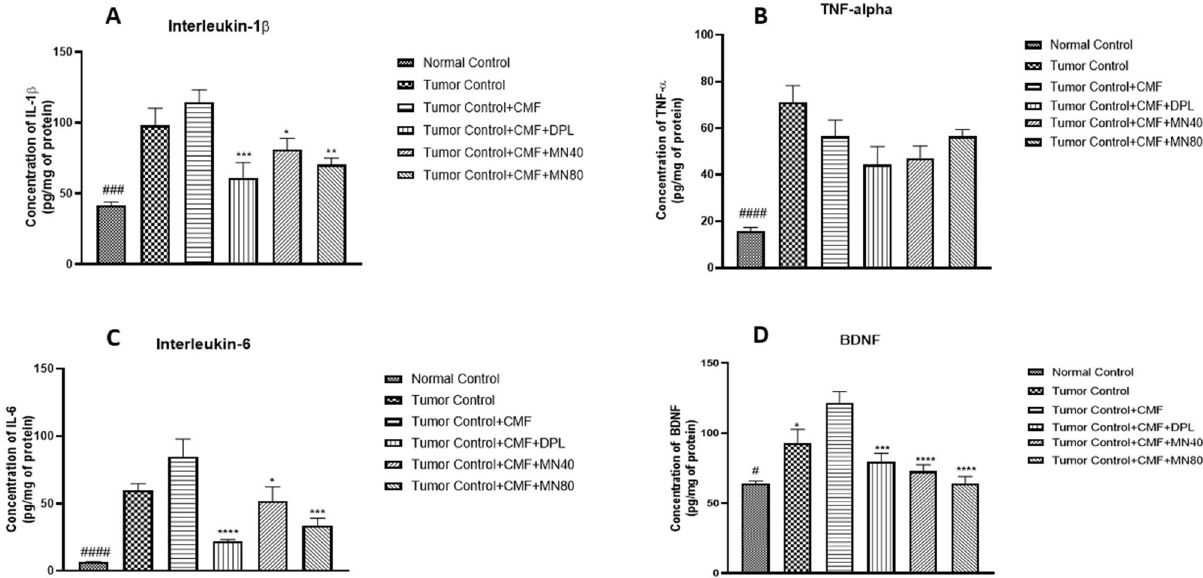
Figure 9. Effect of Mulmina (MN), Cyclophosphamide + Methotrexate + 5-Fluorouracil (CMF), Donepezil (DPL) on A) IL-1β B) TNF-α C) IL-6 D) BDNF on tumor-bearing animals. Values are expressed as mean ± SEM (n = 3–4). Statistical analysis was done by using one-way ANOVA followed by Dunnet’s post-hoc test .* p < 0.05,** p < 0.01, *** p < 0.001,**** p < 0.0001 compared to tumor + CMF treated group.#p<0.05, ###p<0.001, ####p<0.0001 compared to tumor control group analysed by unpaired student ’t’